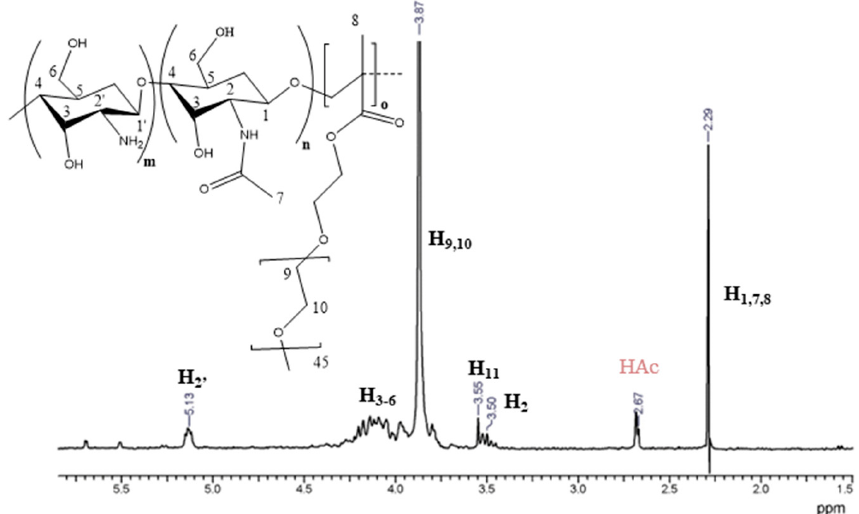
Figure 4. 1 H-NMR spectrum of chitosan- b -poly(PEGMA 2000 ) in D 2 O/DCl at 30 °C.